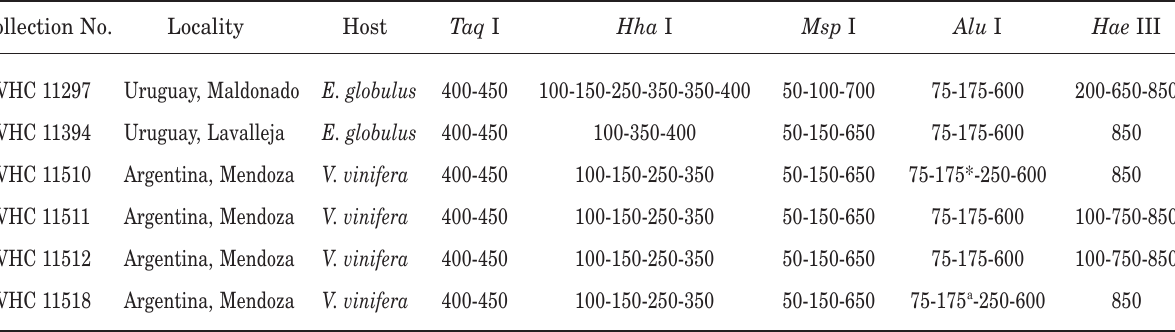
Table 2. ITS restriction fragments obtained with endonucleases. Collection